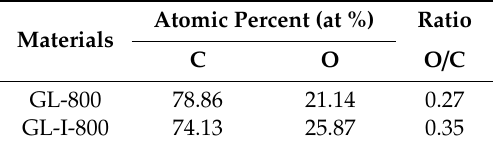
Table 3. Elemental analysis from X-ray photoelectron spectroscopy